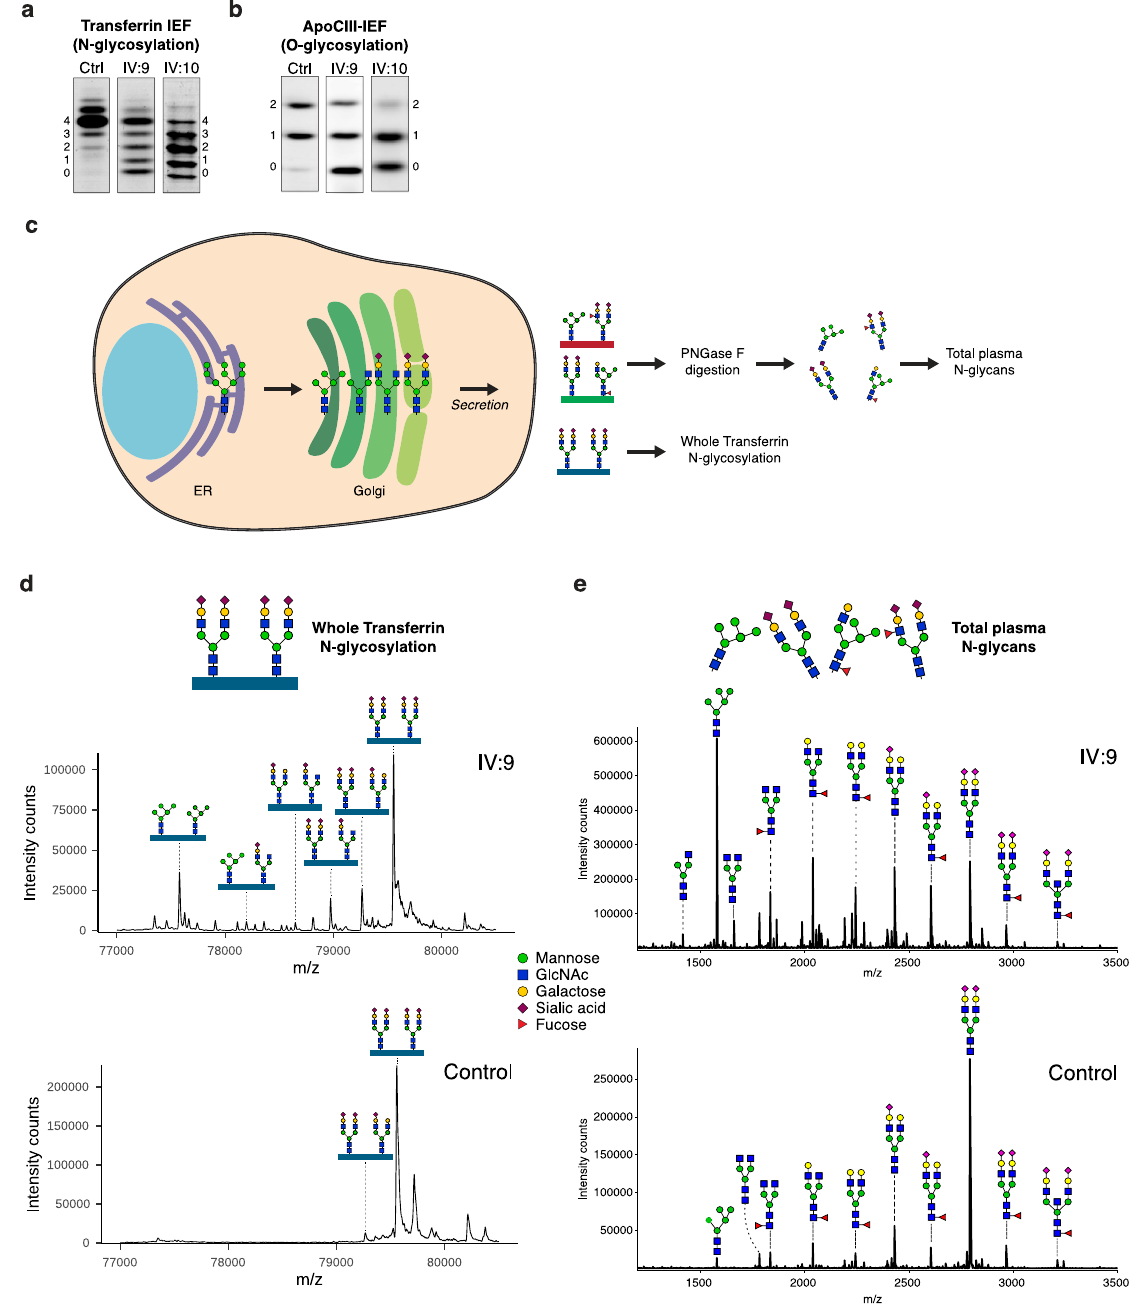
Fig. 1 A novel, lethal, genetic variant suggests a defect in protein glycosylation related to Golgi traf fi cking. a Glycosylation screening by isoelectric focusing (IEF) of serum transferrin. The accompanying numbers represent the total number of sialic acids in the different proteoforms. Both patients show a reduction in the number of sialic acids. Quanti fi cation of bands is shown in Supplementary Table 2. b Glycosylation screening by IEF of serum apolipoprotein C3 (ApoCIII). ApoCIII has one mucin-type O -linked glycan with one or two sialic acids in controls. Both patients show a reduction in the number of sialic acids. Quanti fi cation of bands is shown in Supplementary Table 2. c Schematic overview of N -glycosylation intermediates in the Golgi. For mass spectrometry analysis of glycan structures, glycosylated transferrin was enriched from all secreted glycoproteins in human serum and subjected to intact protein mass spectrometry. In parallel, a different serum sample was treated with PNGase F to cleave and analyze N -glycans from all plasma proteins. d Nanochip-C8 QTOF mass spectra of enriched intact serum transferrin of Stx5M55V patient IV:9 (top spectrum) and healthy control (lower spectrum). Key transferrin glycoforms are shown, indicating a strong increase of high-mannose glycans and glycans lacking sialic acid and galactose. Annotation of all peaks of patients IV:9 and IV:10 is shown in Supplementary Table 3. e MALDI-TOF mass spectra of total plasma N -glycans of Stx5M55V patient IV:9 (top spectrum) and healthy control (lower spectrum). Structural analysis shows a strong increase of high-mannose glycans and glycans lacking sialic acid and galactose. Annotation of all peaks of patients IV:9 and IV:10 is shown in Supplementary Table 4.